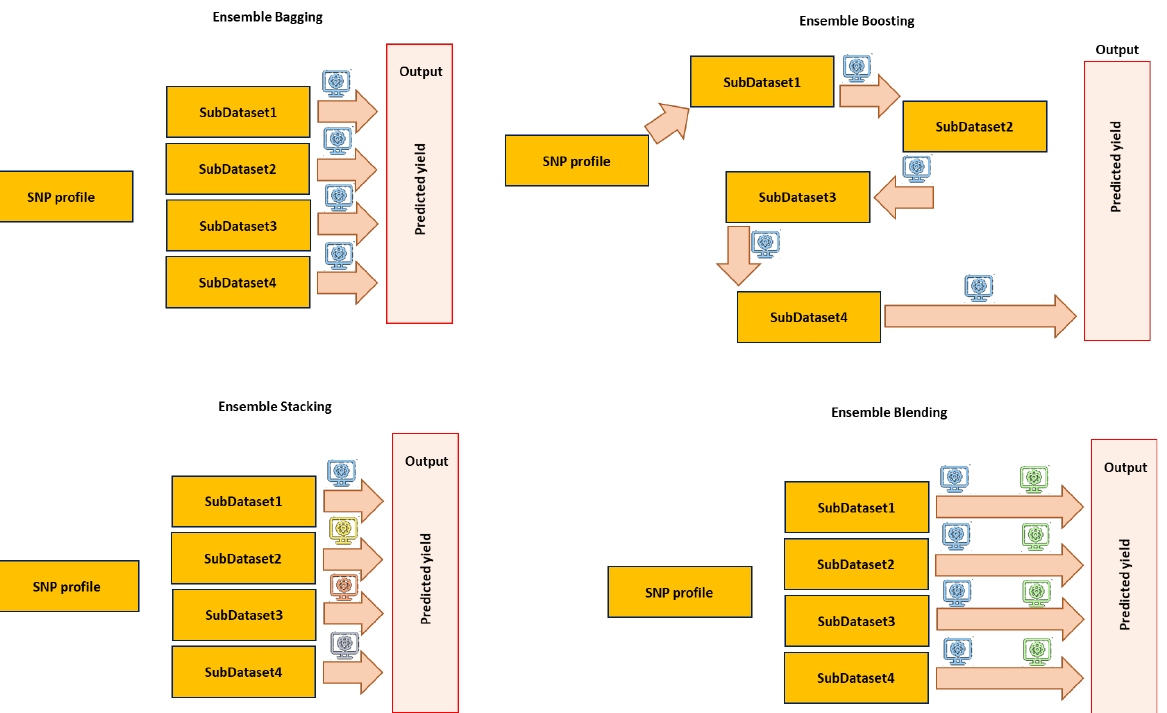
Figure 5. Schematic illustration of different ensemble strategies used for predicting an output (yield as an example) using molecular genetic markers, i. e., SNPs, dataset. Different colors in the compu- an example) using molecular genetic markers, i.e., SNPs, dataset. Different colors in the computational tational logos represent different ML algorithms in each ensemble method. Th is figure was created logos represent different ML algorithms in each ensemble method. This figure was created using using Excel, Microsoft O ffice 2021. Excel, Microsoft Office